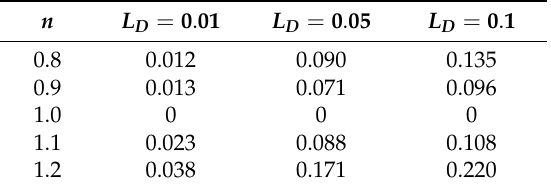
Figure 7. Dimensionless flow rate according to fluid behavior index ( (cid:1866) ) for different Debye lengths ( (cid:1838) (cid:3005) ) with a fixed zeta potential ratio ( (cid:1852) (cid:3019) = 1.5 ). Table 1. Flow rate error (%) between approximate solution and numerical analysis at (cid:1852) (cid:3019) = 1.5 .